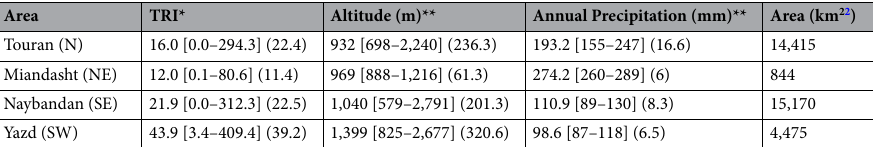
Table 1. Terrain roughness index (TRI), Altitude (m), Annual Precipitation (mm), Area (km 2 ) of each study area, including mean, [minimum–maximum], and (standard deviation). *Extracted from Wilson et al. 92 ; **Extracted from Fick and Hijmans 93 . Subpopulations are indicated as Northern (N), North-eastern (NE), South-eastern (SE) and South-western